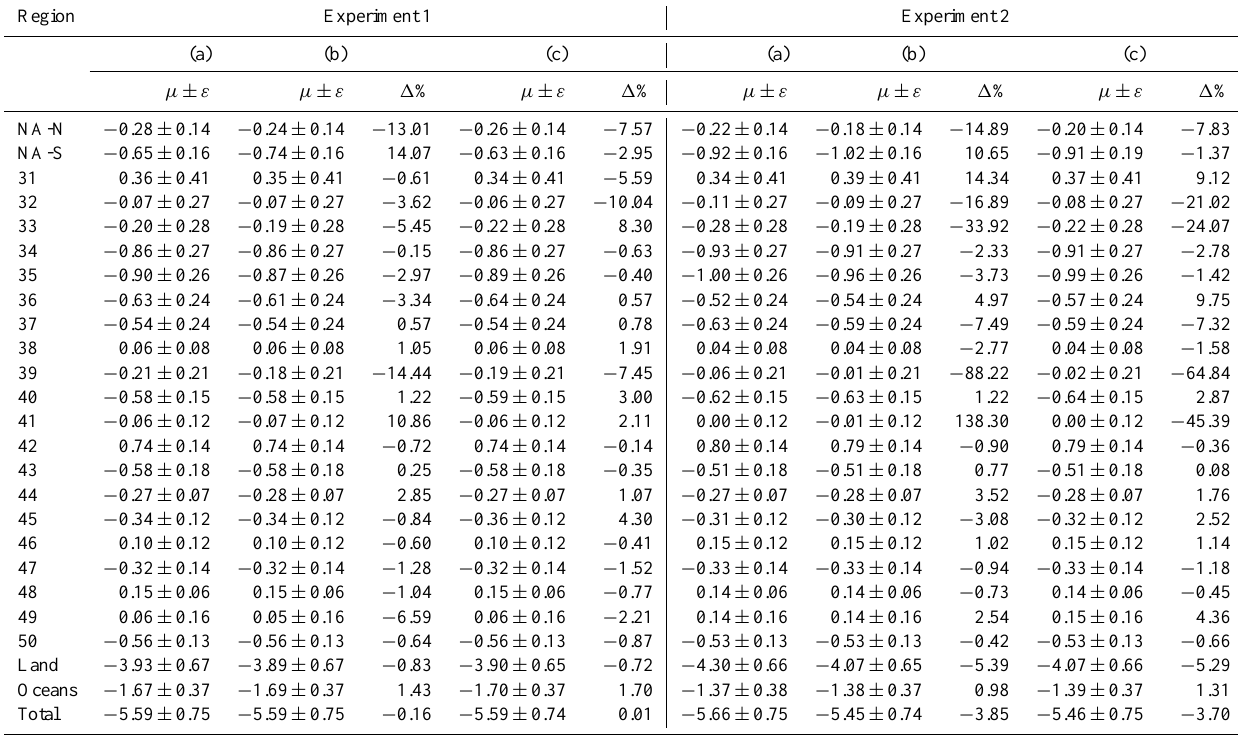
Table 6. Mean inverted CO 2 flux ( µ) , error ( ε) in PgCyr − 1 , and the percentage change ( (cid:49) %) for global regions from 2002 to 2007.